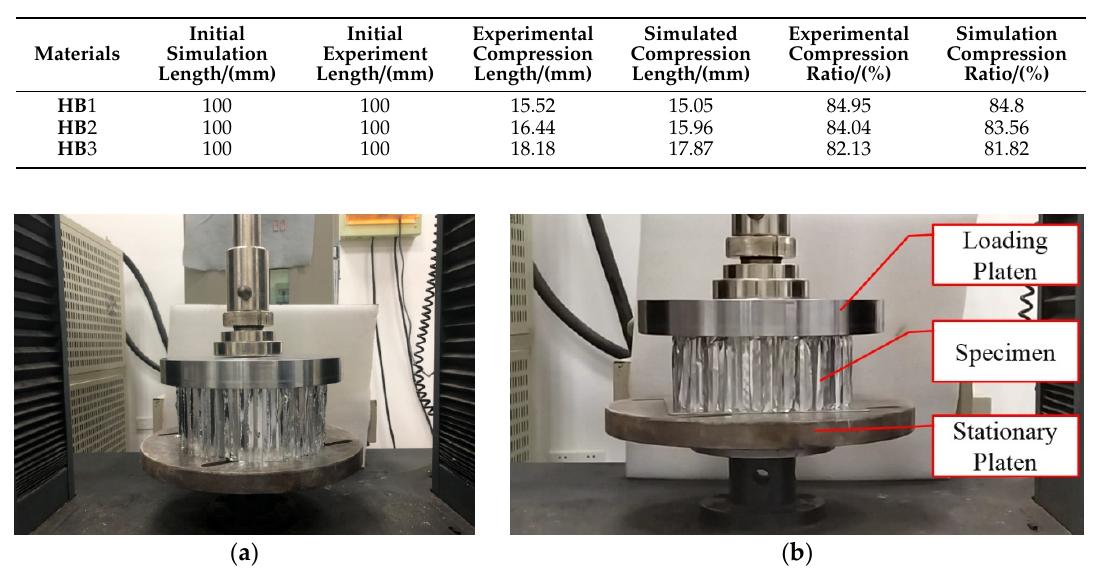
Figure 5. Static pressure experiment of material. ( a ) Placement of experimental material, ( b )The process of static pressure experiment .